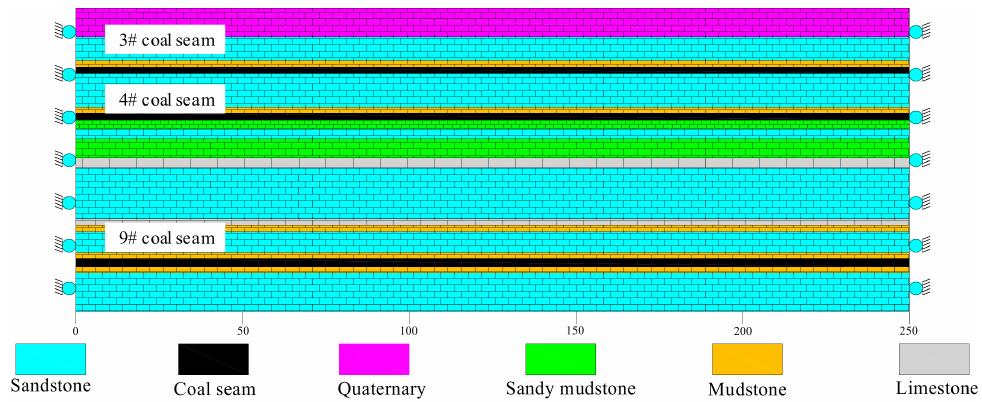
Figure 13. Numerical simulation calculation